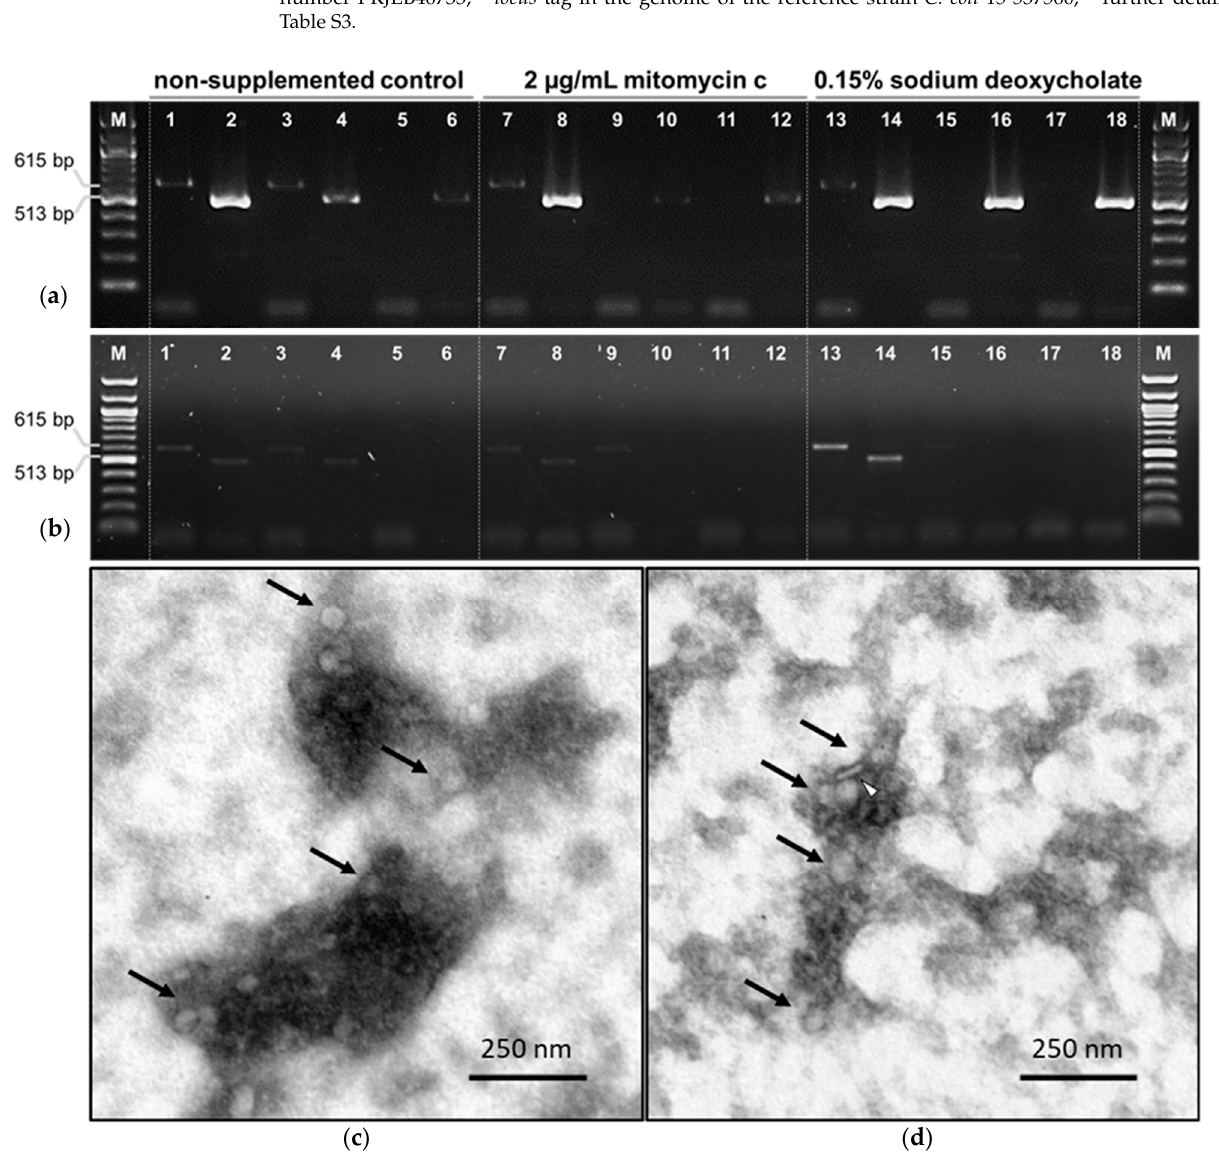
Figure 2. Prophage induction assays. ( a , b ) PCR detection of CJIE1 ( a ) and CCIE1 ( b ) circular phagic